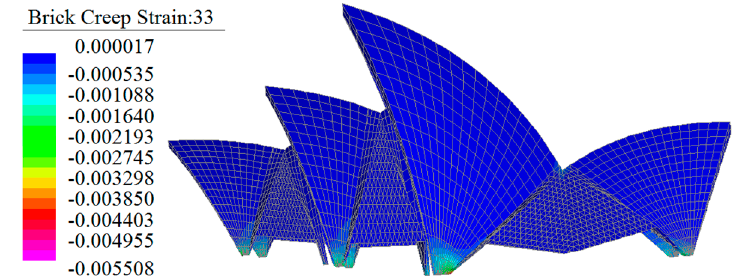
Figure 6. Strand7 creep strain contour (unscaled).